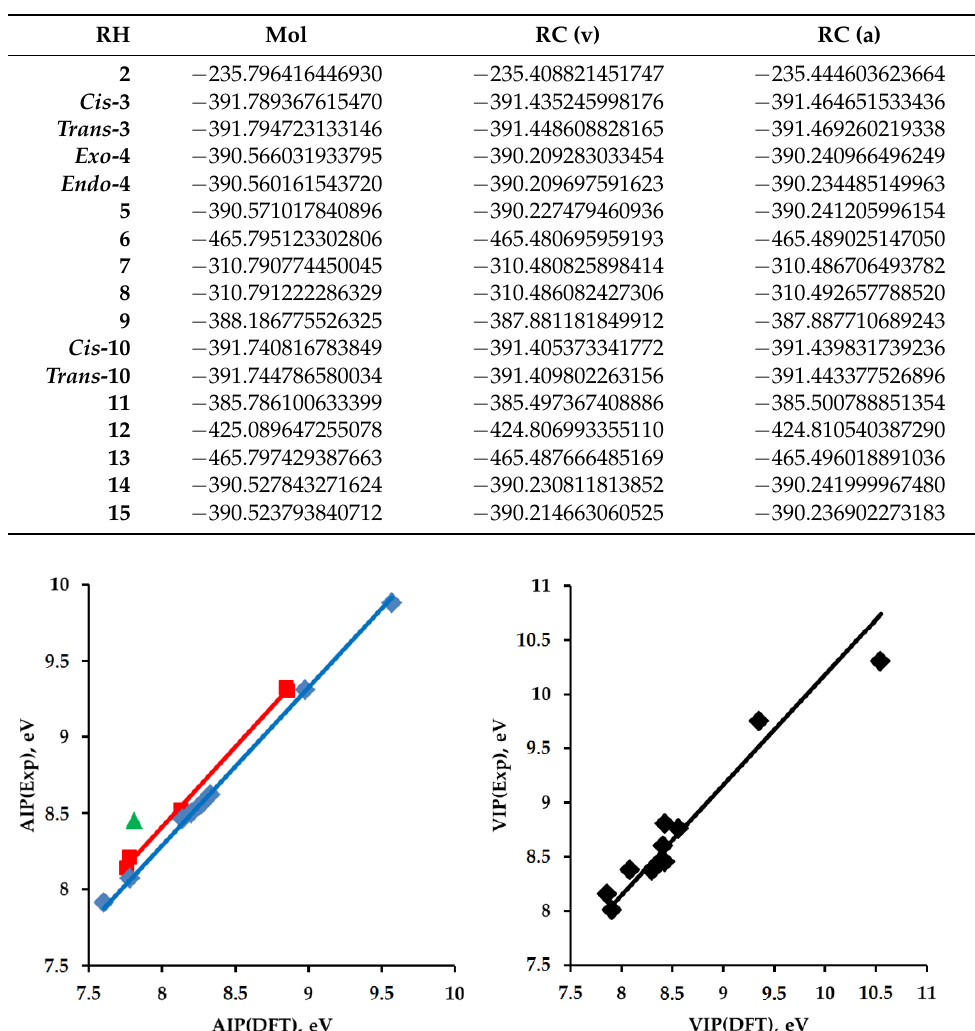
Table 4. DFT calculated energies (E h ) of molecules ( Mol ) and radical cations ( RC ) of RH .